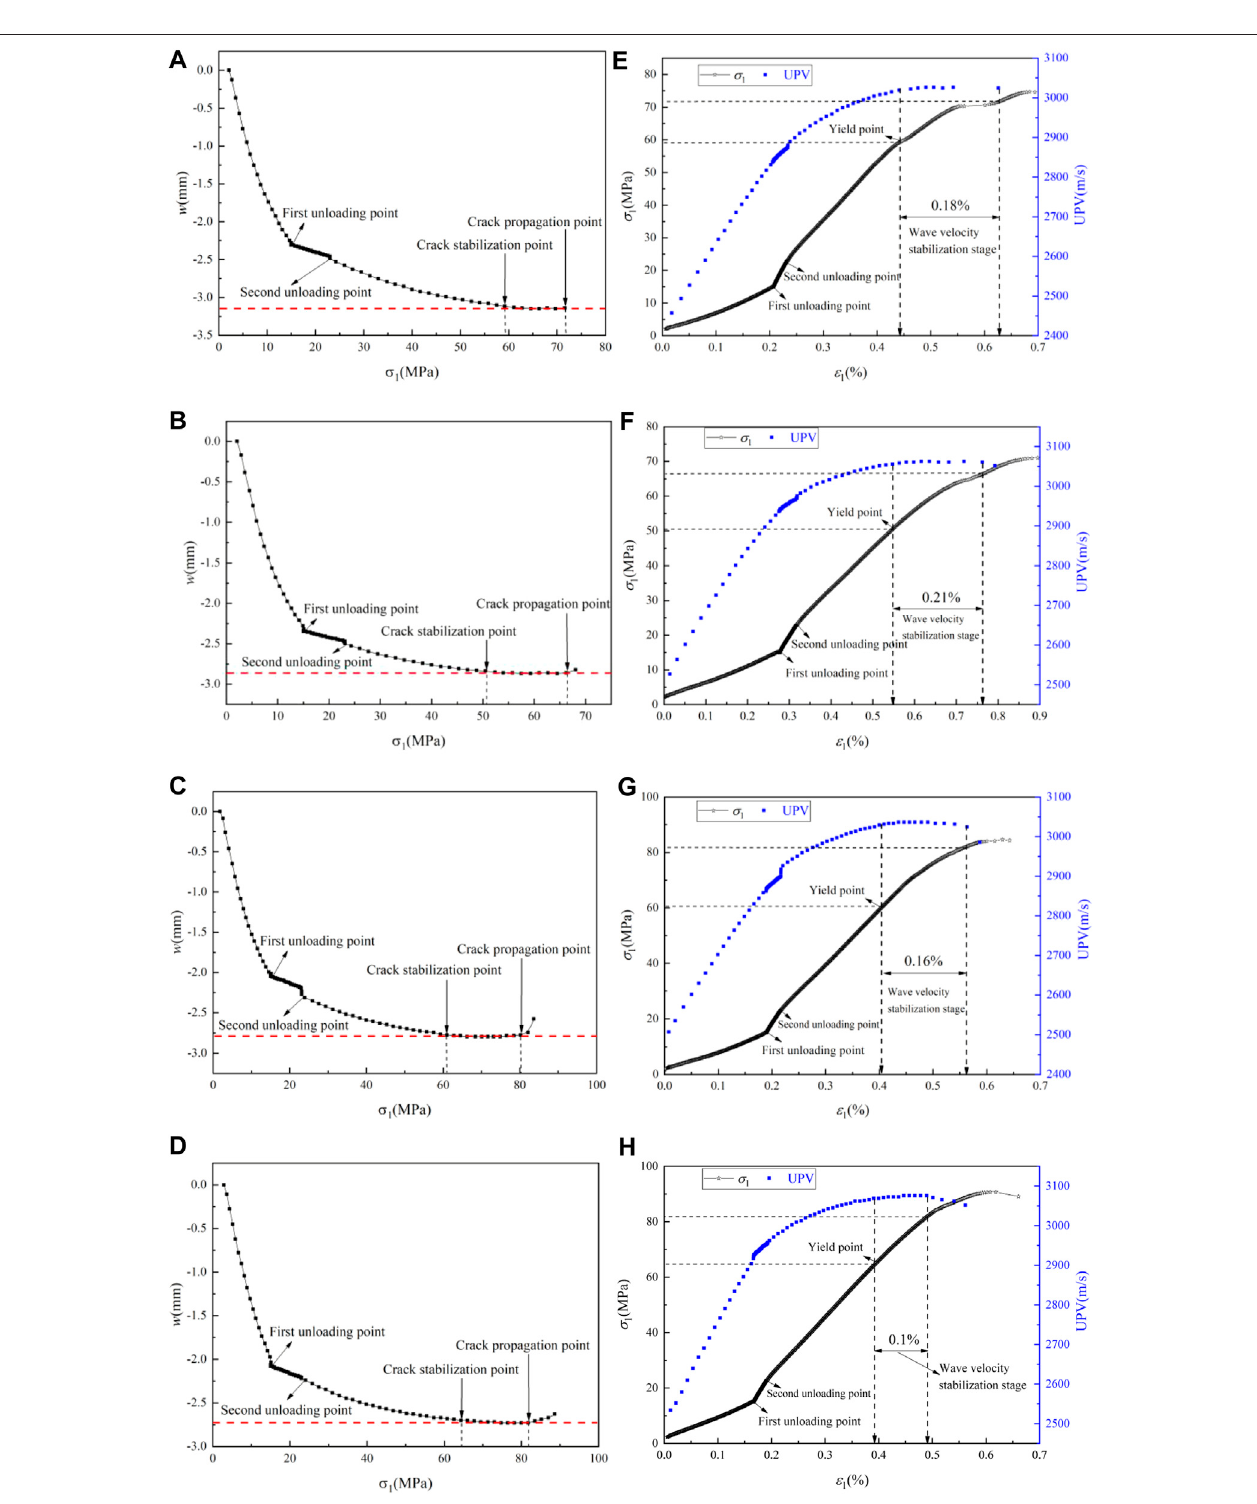
FIGURE 10 | The relationship between axial stress and total crack width (A,B,C,D) , and between wave velocity and axial strain (E,F,G,H) of cracked sandstone specimens with different inclination angles.